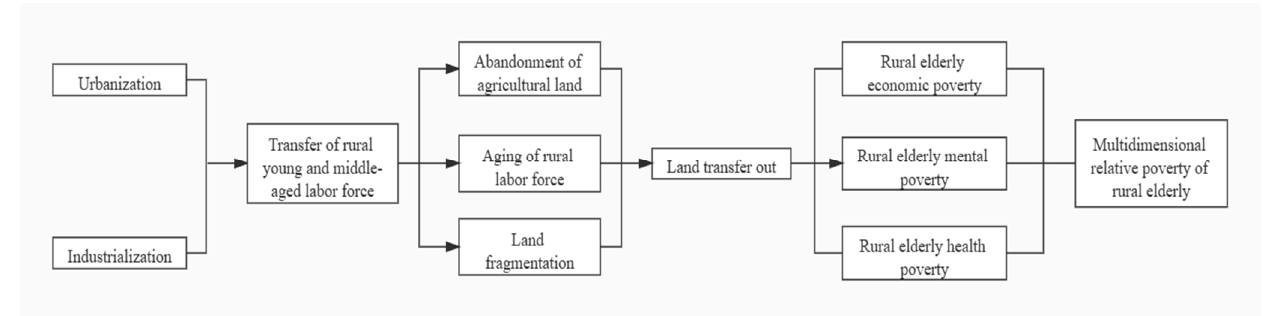
Figure 1. Theoretical analysis framework.